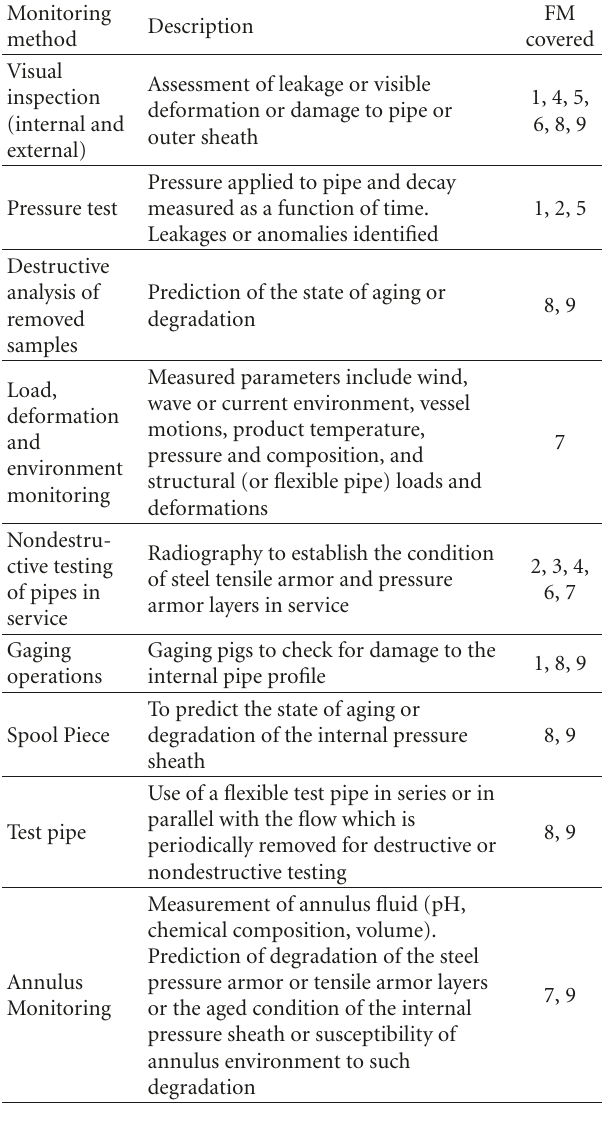
Table 3: Flexible riser inspection and monitoring techniques suggested by API 17B and the failure modes (FM) covered by each